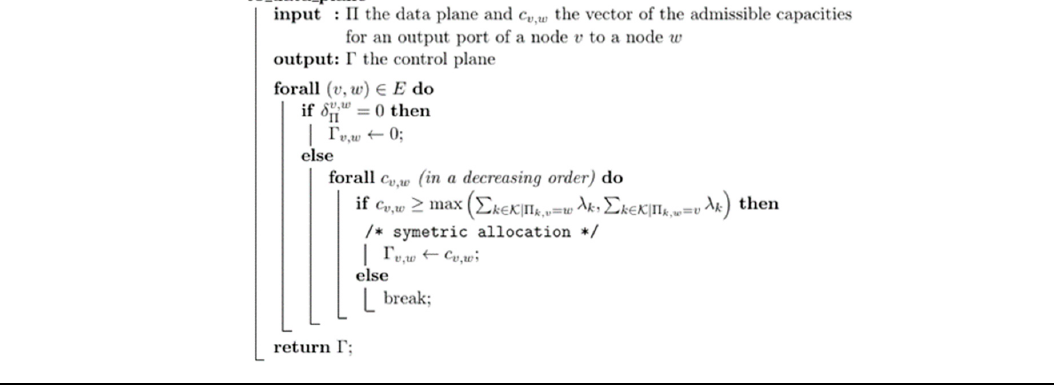
Algorithm 2. Computation of the minimum control plane from given data plane. Algorithm 3. The Full Algorithm. Sensors 2019 , 19 , 2901